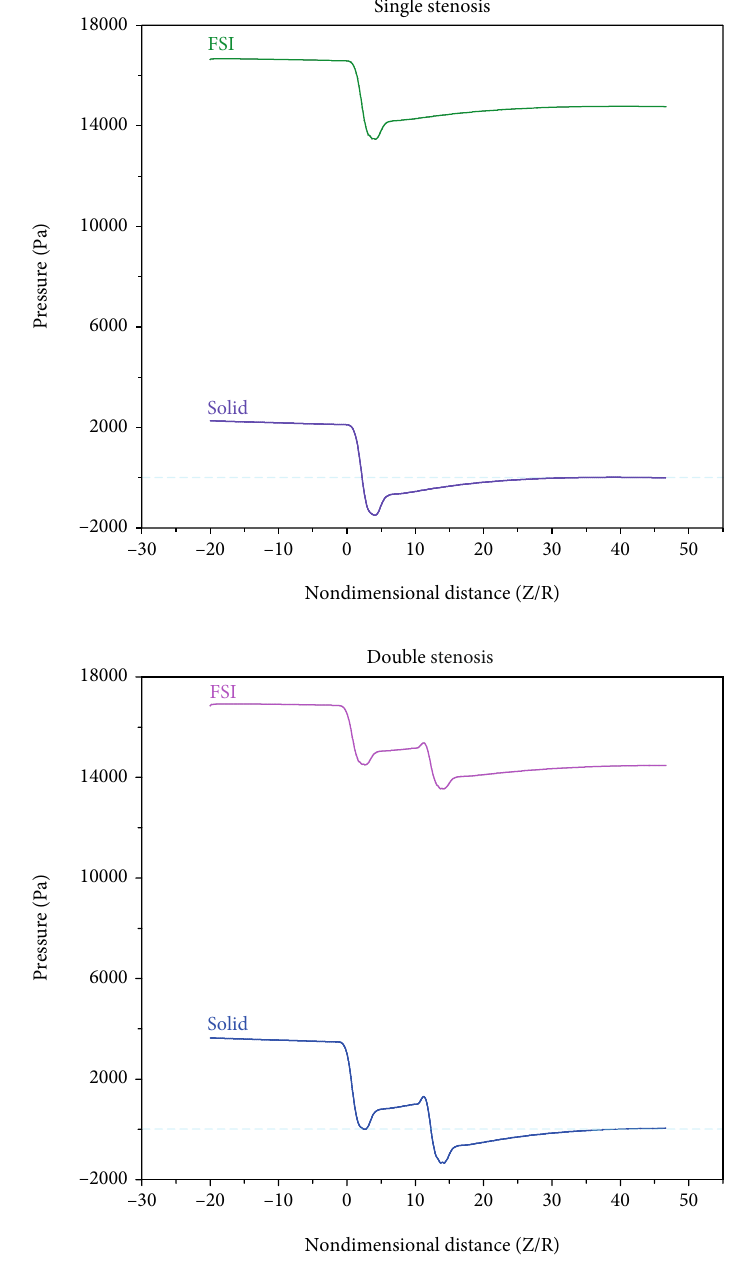
Figure 6: The axial pressure drops of the rigid and elastic